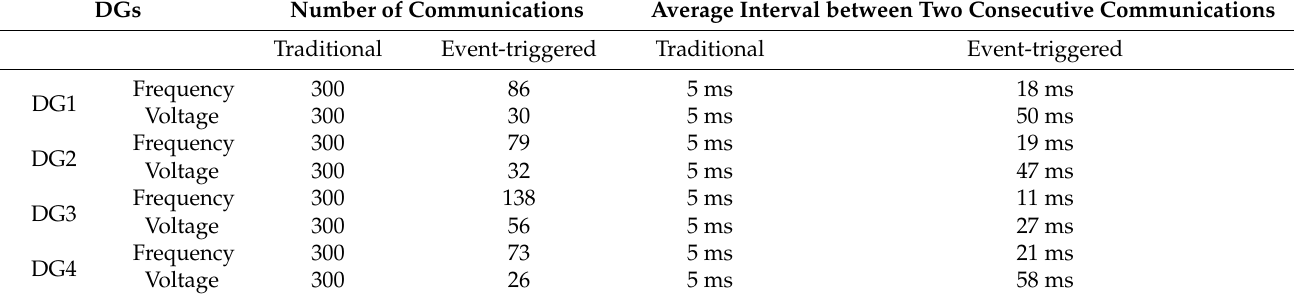
Table 2. Communication result.